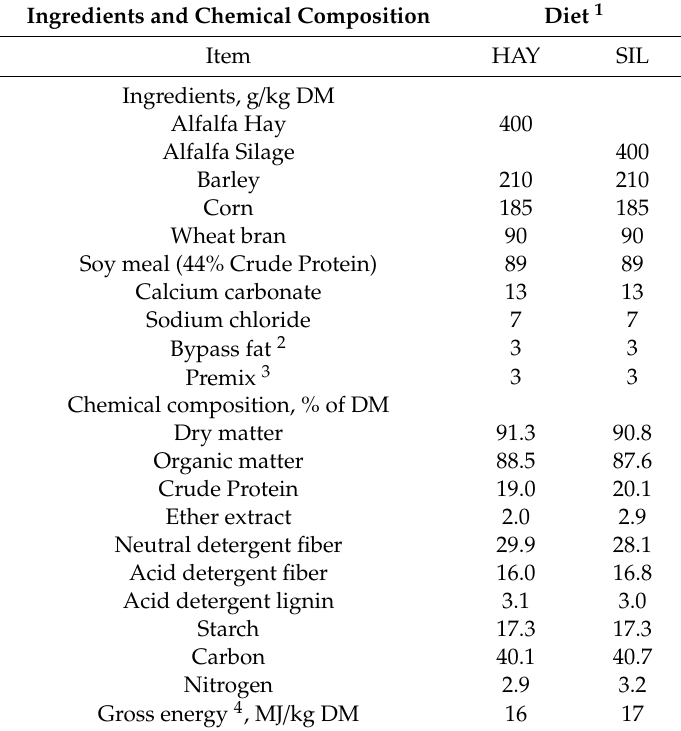
Table 1. Ingredients and chemical composition of the